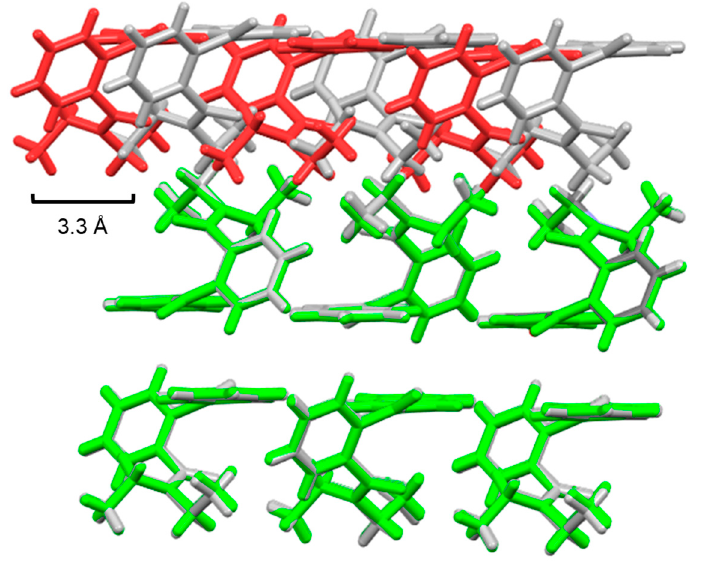
Figure 5. Crystal packing similarity between forms II (in grey—reference) and III (colored). Green are molecules that confirm similar packing of forms II and III for 15 out of 20 molecules. Molecules in red do not match with the packing of form II.